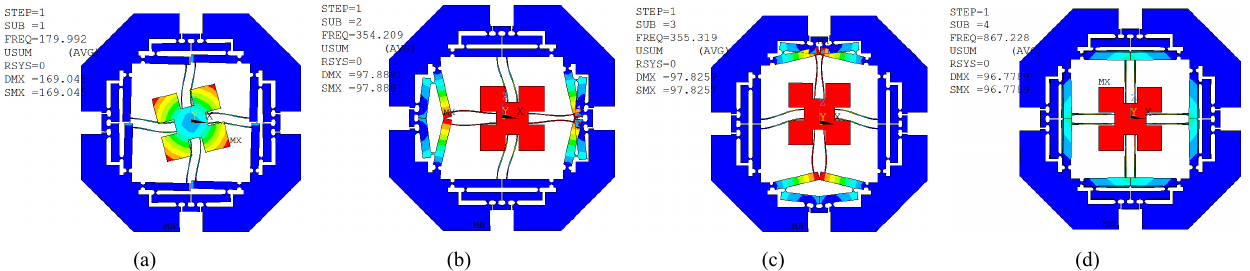
Figure 12. The first four modal shapes of the mechanism: (a) the first modal shape; (b) the second modal shapes; (c) the third modal shape; (d) the fourth modal shape.